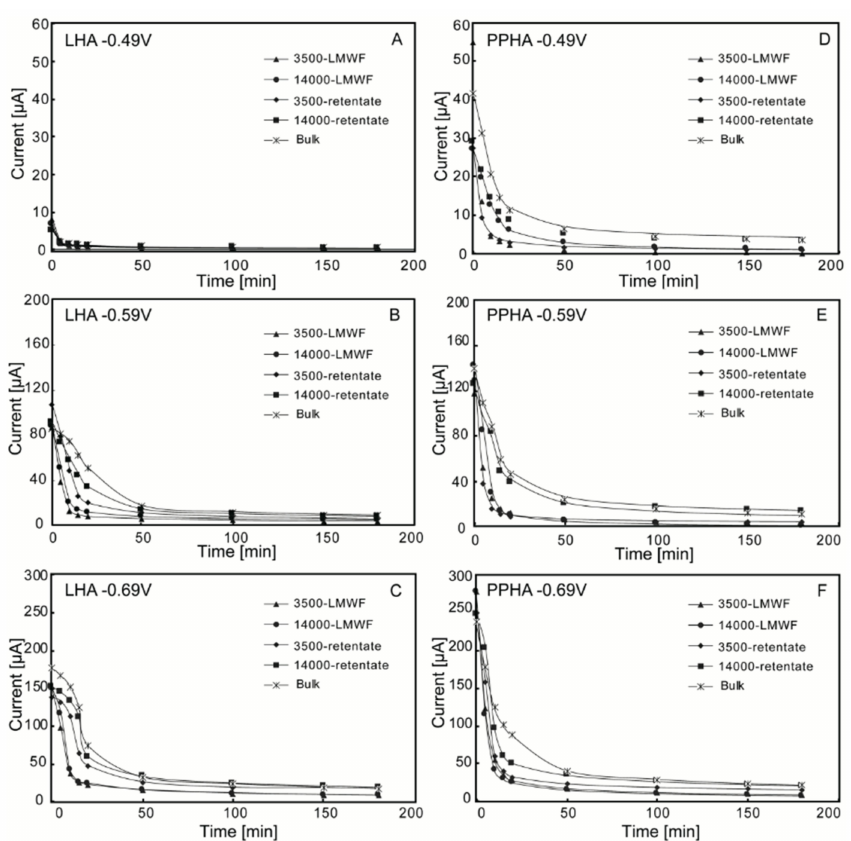
Figure 3. The I–t curve of different molecular weight fractions of LHA and PPHA in direct electro- chemical reduction, which was carried out at Eh = − 0.49 V, Eh = − 0.59 V, and Eh = − 0.69 V for